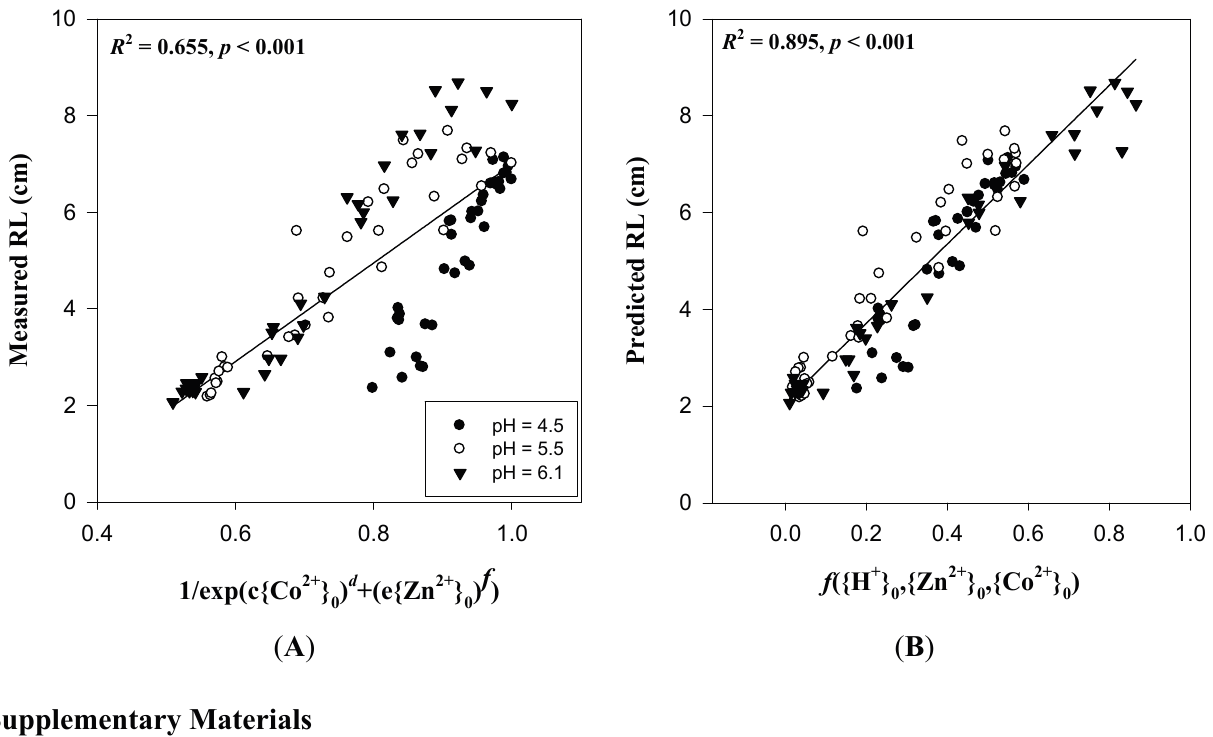
Figure 7. Comparison of the measured ( A ) and predicted ( B ) root length (RL) when wheat seedlings were exposed to Zn-Co mixtures. Predicted RL was based upon extended multiplicative models using ion activities at PM surfaces ({Zn 2+ } 0 and {Co 2+ } 0 ). The solid lines show the linear regression. The details of the coefficients c and e (Equation (19)) and the function f ({H + } 0 ,{Zn 2+ } 0 ,{Co 2+ } 0 ) (Equation (20)) are described in Table S2. Data were obtained from Wang et al.